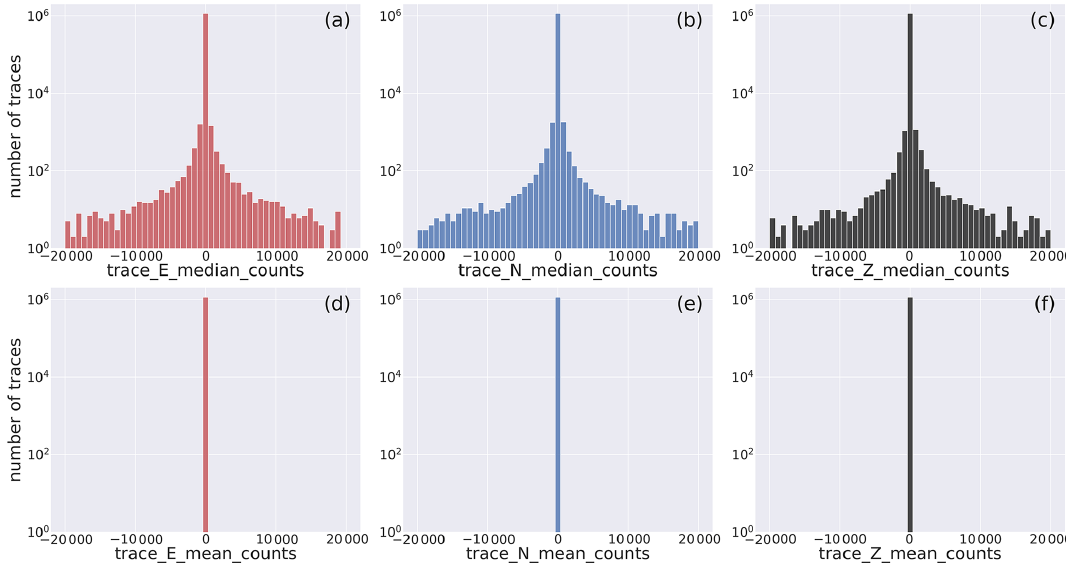
Figure D2. Histogram of the distribution of the quality control metadata of the full earthquake dataset, with the horizontal axis inclusive of the complete range of values: median (a–c) and mean (d–f) . The width of the bins is 2 × 10 3 ; axes are labeled according to the metadata listed in Table